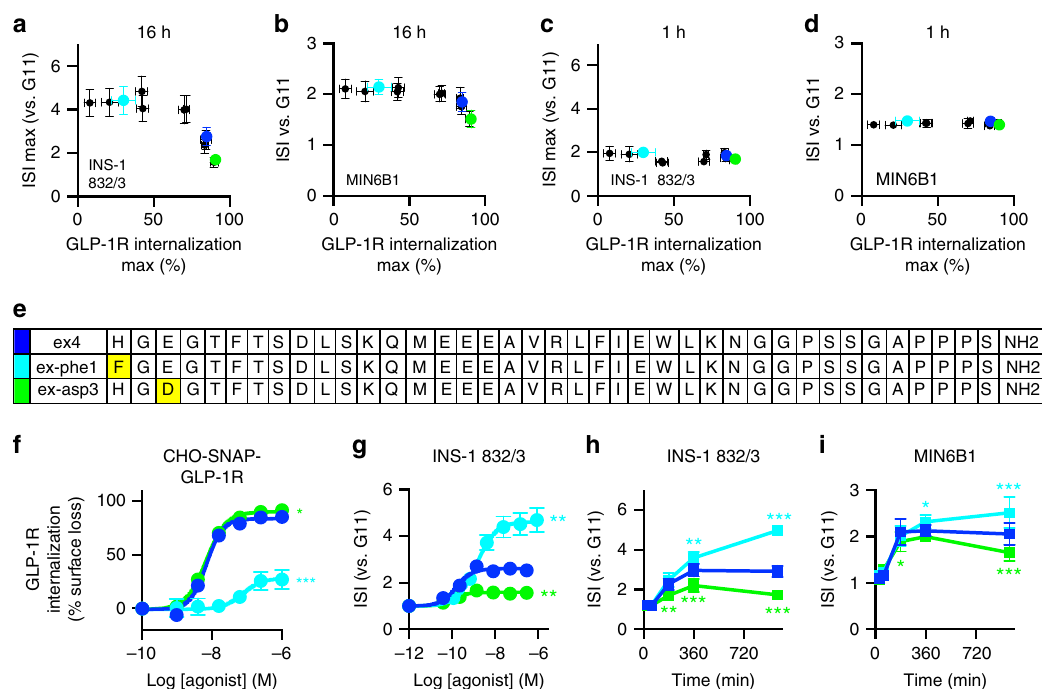
Fig. 1 Insulin secretion is predicted by agonist-induced GLP-1R endocytosis. a Relationship between maximal agonist-induced SNAP-GLP-1R internalization in CHO-SNAP-GLP-1R cells (90 min, n = 5) and maximal prolonged insulin secretion in INS-1 832/3 cells (16 h, n = 6), expressed as insulin secretion index (ISI), i.e., fold increase vs. 11 mM glucose (G11) alone; full data in Supplementary Fig. 1. b As for a , but insulin secretion with 100 nM agonist in MIN6B1 cells, n = 7. c , d As for a , b , respectively, but over 1 h, n = 5. e Sequences in single letter amino acid code for exendin-4 (ex4), exendin-phe1 (ex-phe1), and exendin-asp3 (ex-asp3). f Net GLP-1R internalization (90 min) in CHO-SNAP-GLP-1R cells, full data in Supplementary Fig. 1, n = 5, four-parameter fi t and statistical signi fi cance for E max via one-way ANOVA with Dunnett ’ s test vs. exendin-4. g Prolonged insulin secretion in INS-1 832/3 cells, 16 h, n = 5, separate experiments to Supplementary Fig. 1, four-parameter fi t and statistical signi fi cance for E max via one-way ANOVA with Dunnett ’ s test vs. exendin- 4. h Time-course insulin secretion in INS-1 832/3 cells, n = 5, two-way ANOVA with Dunnett ’ s test vs. exendin-4. i As for h , but in MIN6B1 cells, n = 5. Agonists applied at 100 nM, except where indicated. * p < 0.05, ** p < 0.01, *** p < 0.001. Error bars indicate standard error of mean